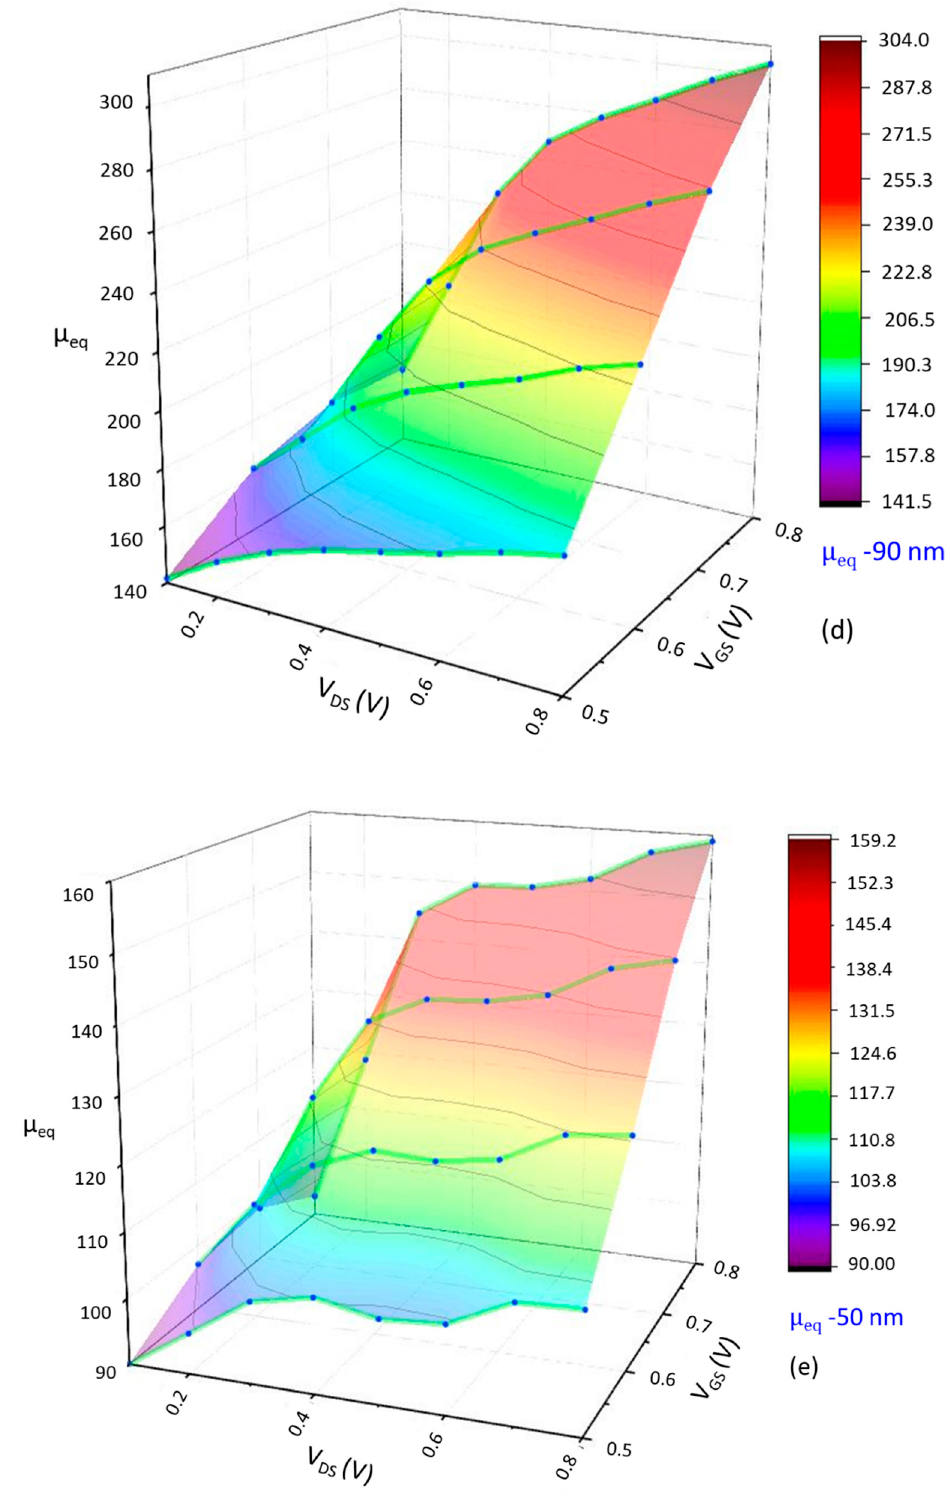
Figure 8. Three dimensions of µ eq versus V DS and V GS at: ( a ) L mask = 500 nm (long-channel) and 33 nm (short-channel), ( b ) L mask = 1 µ m, ( c ) L mask = 120 nm, ( d ) L mask = 90 nm, and ( e ) L mask = 50 nm.